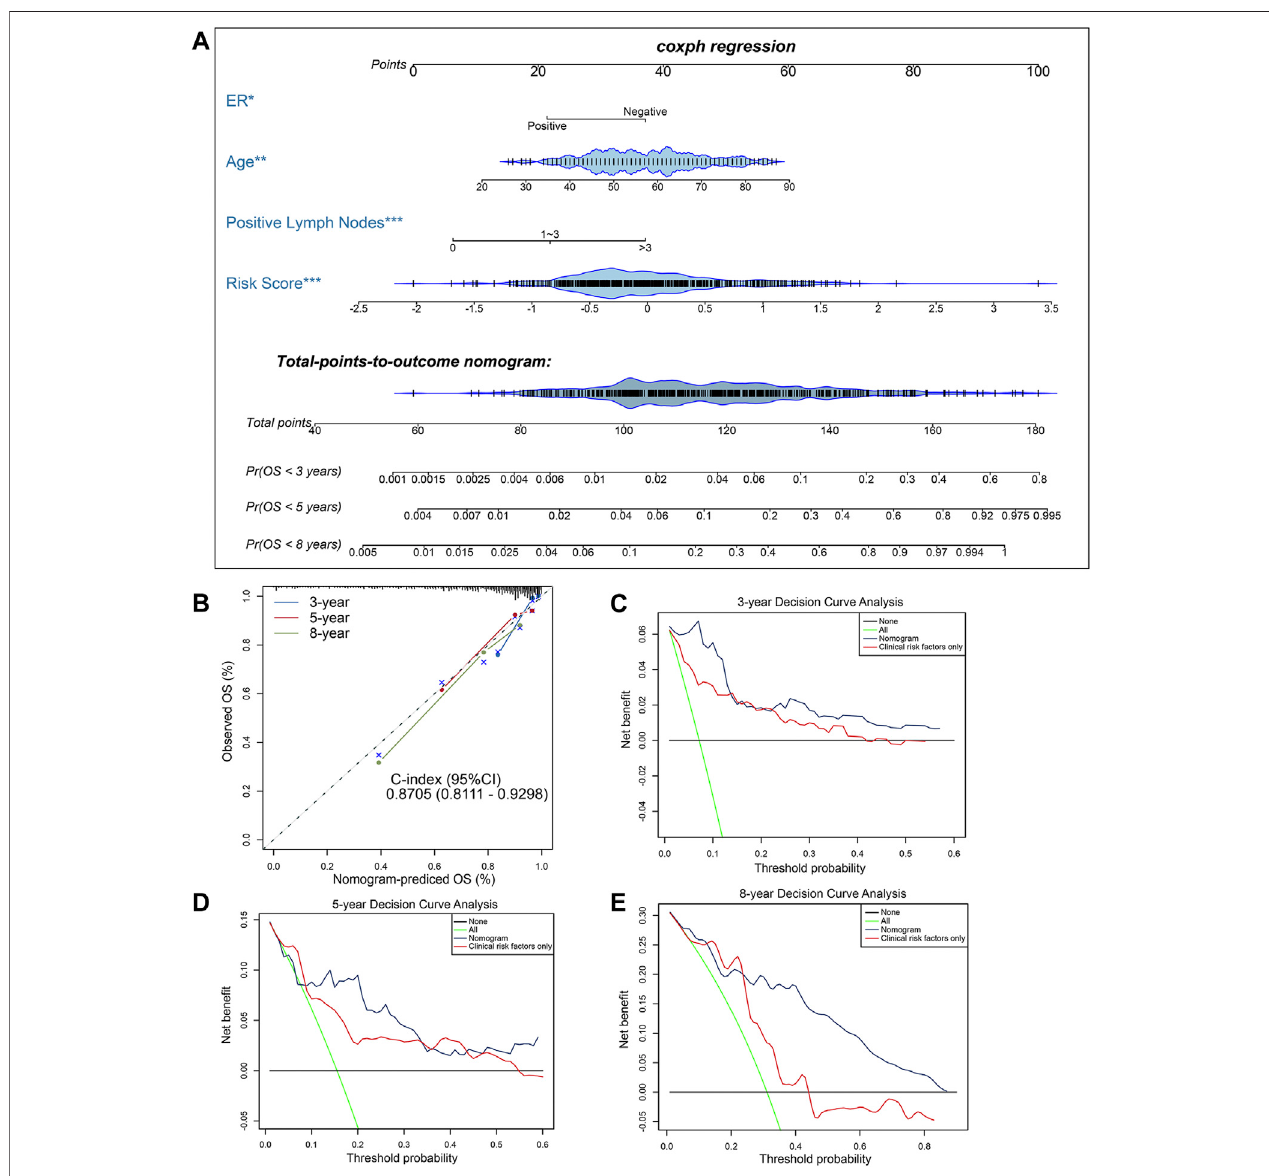
FIGURE4| Constructionandevaluationofaclinicalpredictivemodel. (A) Themethylation-clinicopathologicnomogramforpredictingthe3-,5-and8-yearsoverall survival probability for BC patients, which was developed in the TCGA cohort, with ER status, age, positive lymph nodes status and 10 - CpG-based signature incorporated. (B) Calibration curves and C-index (95% CI) of the nomogram in TCGA cohort. The calibration plot depicts the calibration of the nomogram in term of agreement between observed and predicted 3-, 5- and 8-years clinical outcomes. The dashed 45-degree line indicates the ideal situation, and the dotted lines indicate thepredictive performanceofthemodel. (C – E) Decisioncurve analysisofthenomogram in TCGA cohortforevaluatingtheclinicalusefulnessin (C) 3 years, (D) 5 years and (E) 8 years. The blue line representsthe CpG-clinicopathologic nomogram. The red line represents the model which integrated clinical risk factors only. The black line represents the treat-none scheme. And the green line represents the treat-all-patients